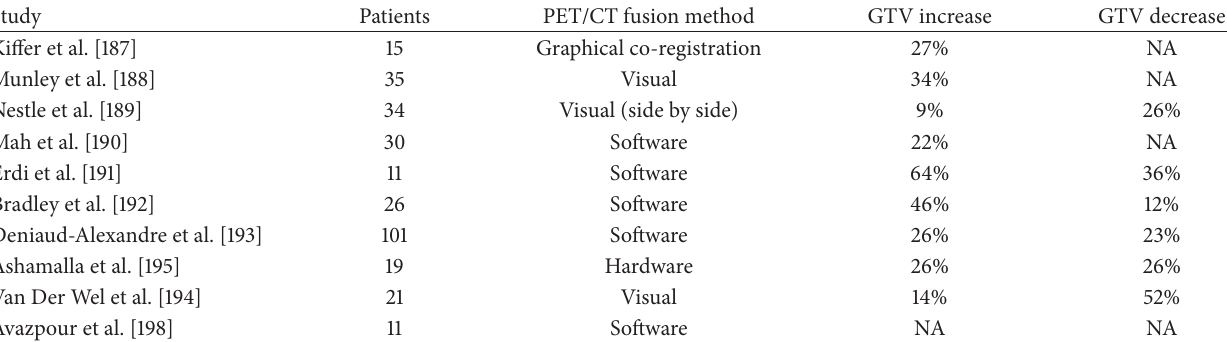
Table 7: Assessing the effect of PET/CT on GTV. For each study, the number of patients, the PET/CT fusion method, and the increase and decrease in the GTV as a percentage of the total number of the study cases are